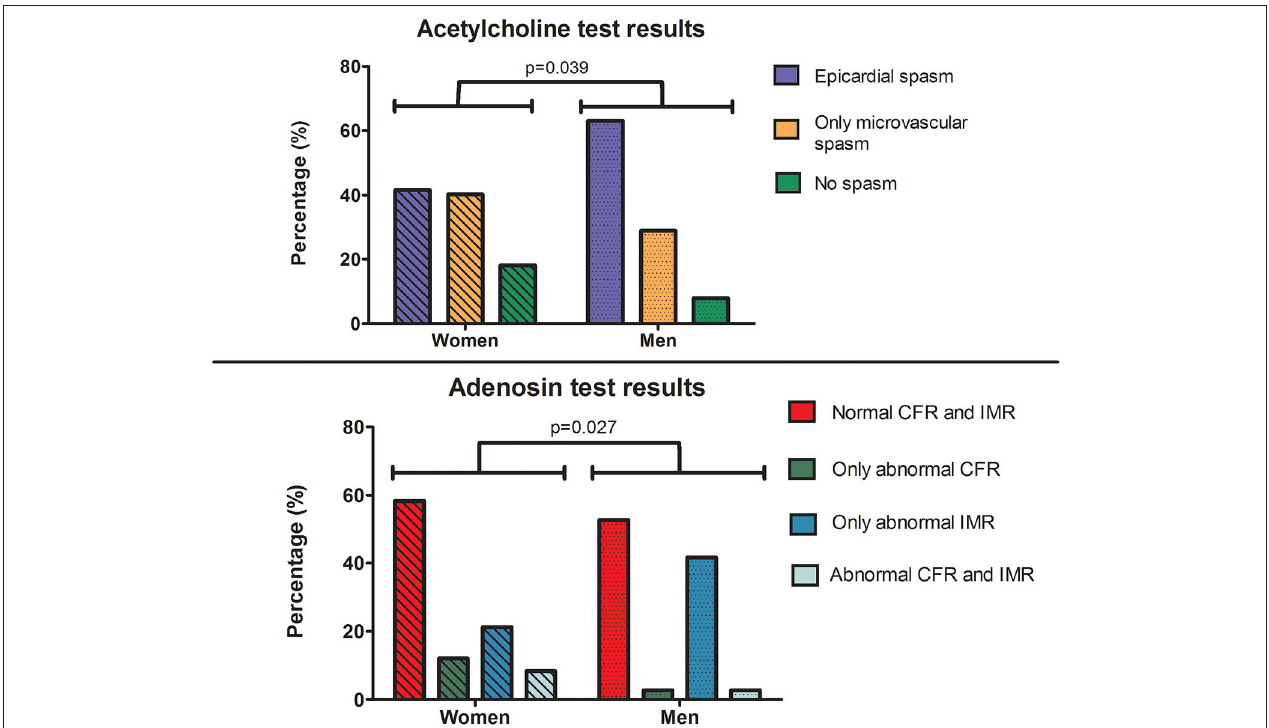
FIGURE 1 | Central illustration: Acetylcholine and adenosine testing result differences between both genders. Top–Acetylcholine spasm testing in patients with angina and no obstructive coronary artery disease showed that men have a higher prevalence of epicardial spasm and a lower prevalence of microvascular spasm compared to women. Please note that the “epicardial spasm” group includes all patients who showed epicardial spasm at one of the dosages ACH, some of these patients showed signs of microvascular spams at a lower dosage of ACH. Bottom–Adenosine testing of microvascular function in patients with angina and no obstructive coronary artery disease showed that women have increased prevalence of impaired CFR and similar prevalence of impaired IMR. ACH, acetylcholine; ADE, adenosine; CFR, coronary flow reserve; IMR, index of microvascular